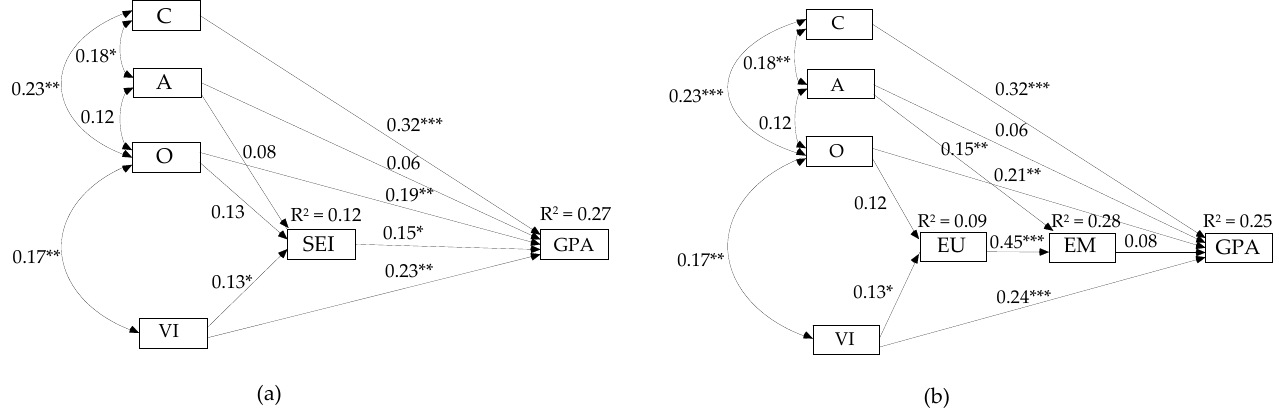
Figure 2. Standardized parameter estimates for the ( a ) mediation and ( b ) “cascading” models. GPA, grade point average; VI, verbal intelligence; A, agreeableness; C, conscientiousness; O, openness; SEI, strategic emotional intelligence; EU, emotion understanding; EM, emotion management. * p < 0.05, ** p < 0.01, *** p < 0.001.